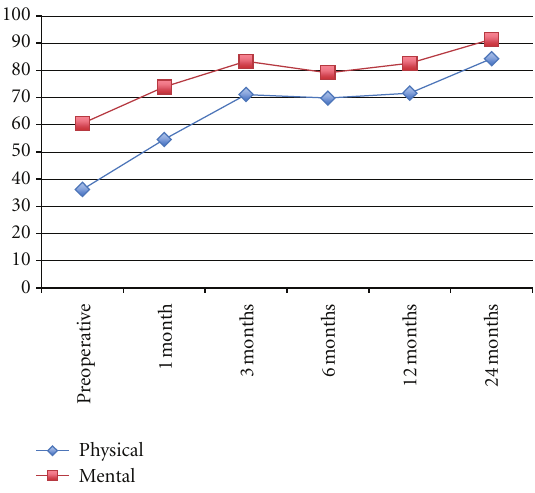
Figure 5: Short Form 36 (SF-36) Health Questionnaire (Physical and Mental) at baseline and 1, 3, 6, 12, and 24 months after operation.